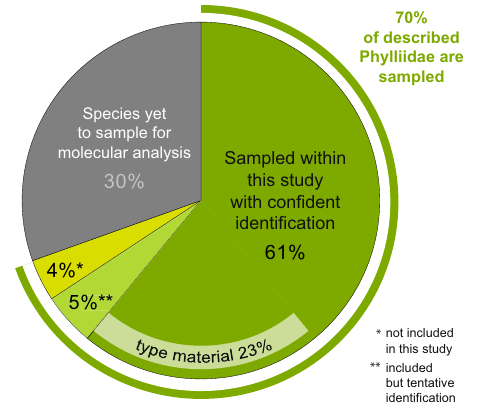
Fig. 3 Pie chart of species coverage. The majority of Phylliidae are sampled with 66% of described species covered in this study, including type material of 24 species and 11 non-type specimens from the type localities (Supplementary Data 2). While the material for 30% of described species was not available, sequence data for 15 – 20 additional and putatively new species were included in our species, which the species delimitation analysis determined as distinct (Fig. 2). Future studies need to explore the potential of the putative new species and clarify their status.